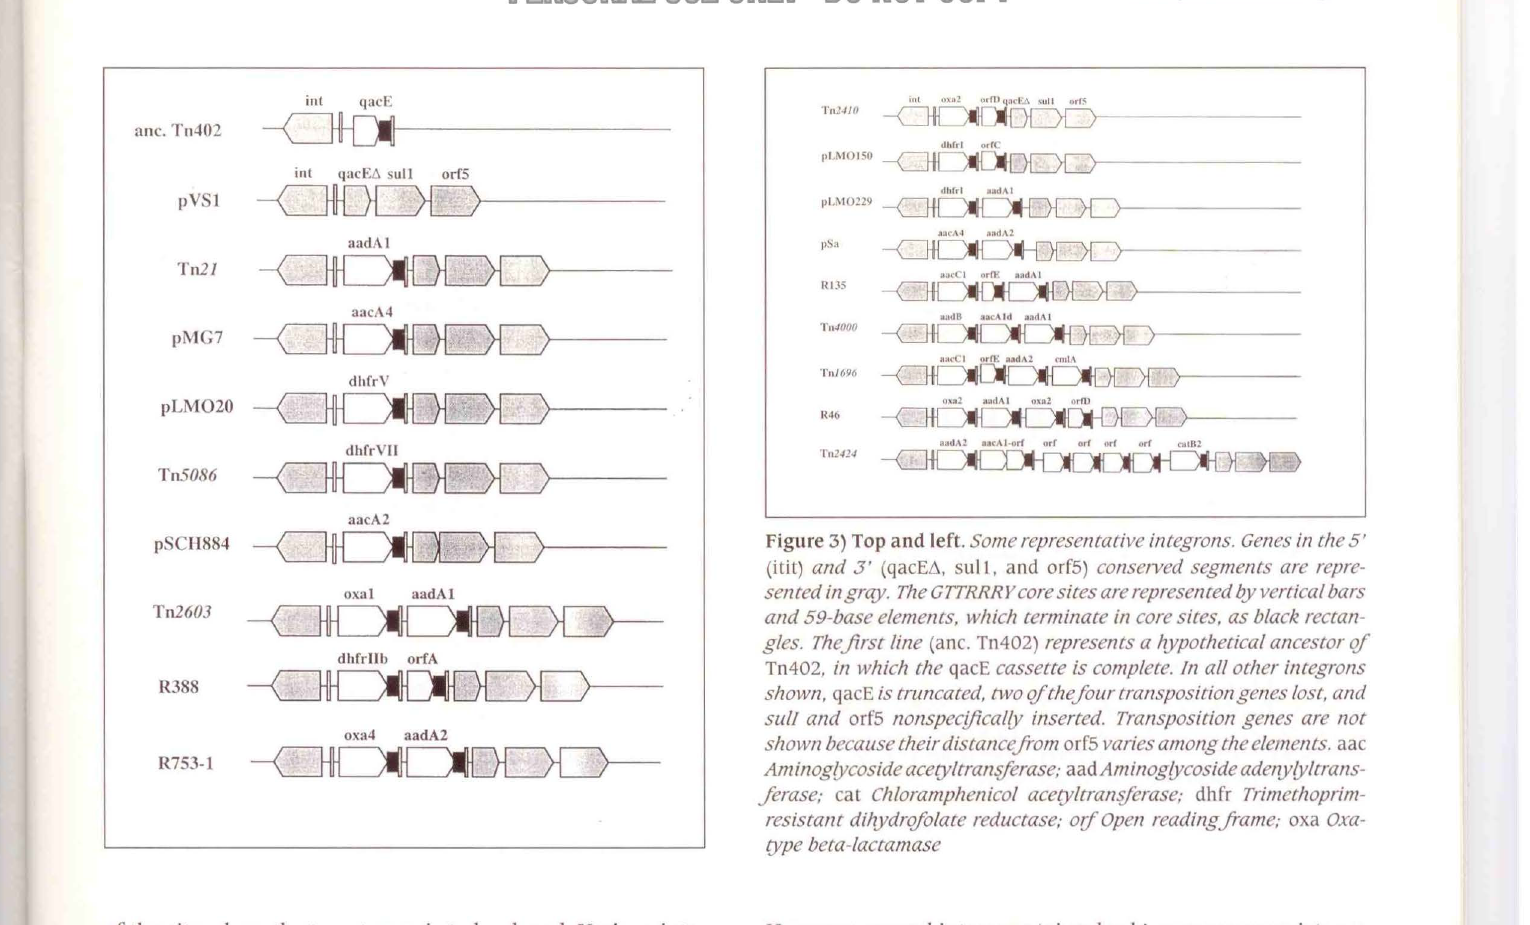
figure 3) Top and left. Some representative integrons. Genes in the 5' (itil) and 3' (qacEL'i., sul !, and orf5) conse,ved segments are repre sented in gray. The G7TRRRY core sites are represented by venical bars and 59-base elements, which terminate in core sites, as black rectan gles. The.first line (anc. Tn402) represents a hypothetical ancestor ef Tn402, in which the qacE cassette is complete. In all other